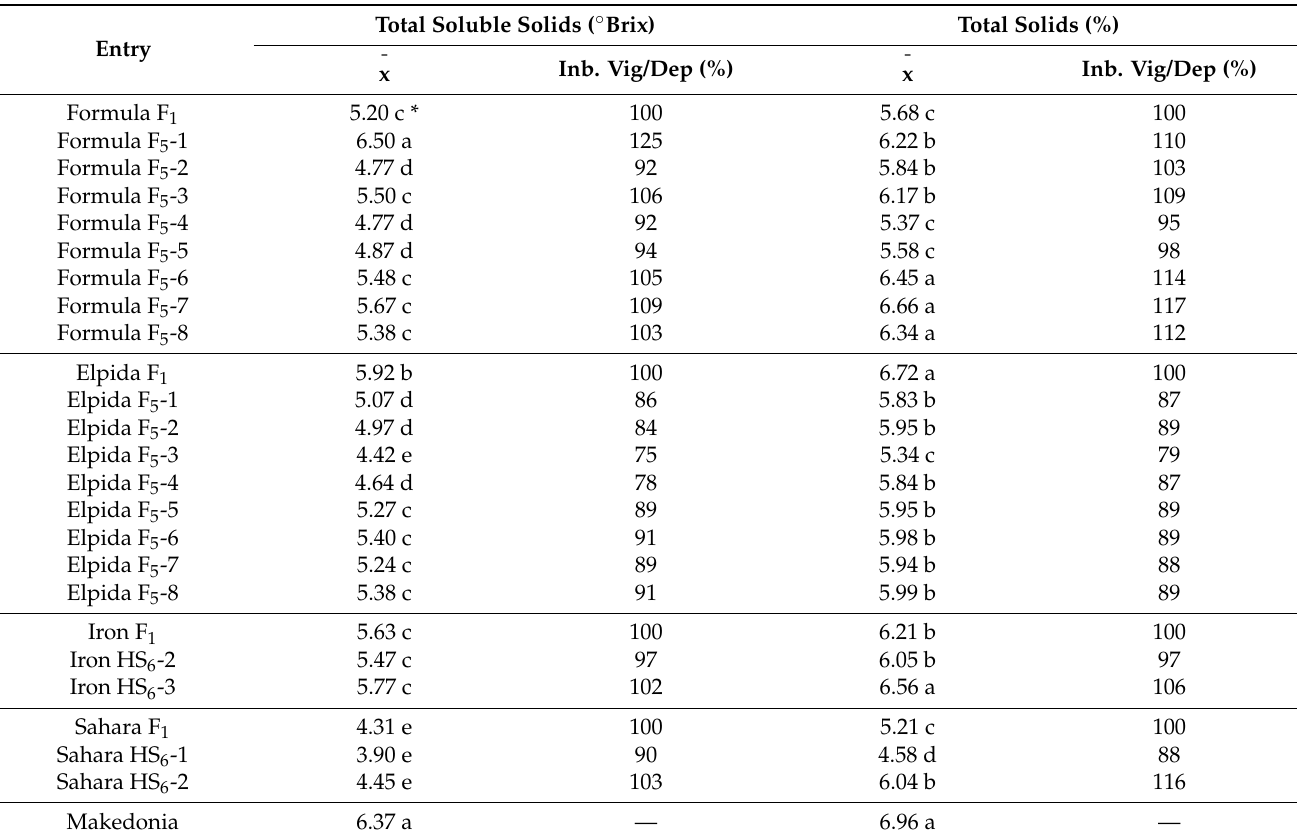
Table 1. Average fruit values for total soluble solids ( ◦ Brix) and total solids (%), and inbred vigor/depression (% of corresponding hybrid), for tomato hybrids and recombinant inbred lines [45].